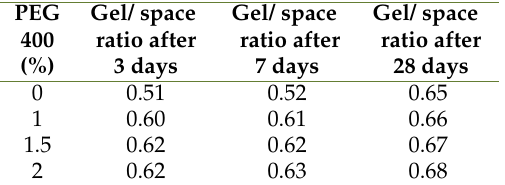
Fig. 10. Gel/Space Ratio at 0.34 Water-Cement Ratio. Table 10. Gel/Space Ratio at 0.55 Water-Cement Ratio.